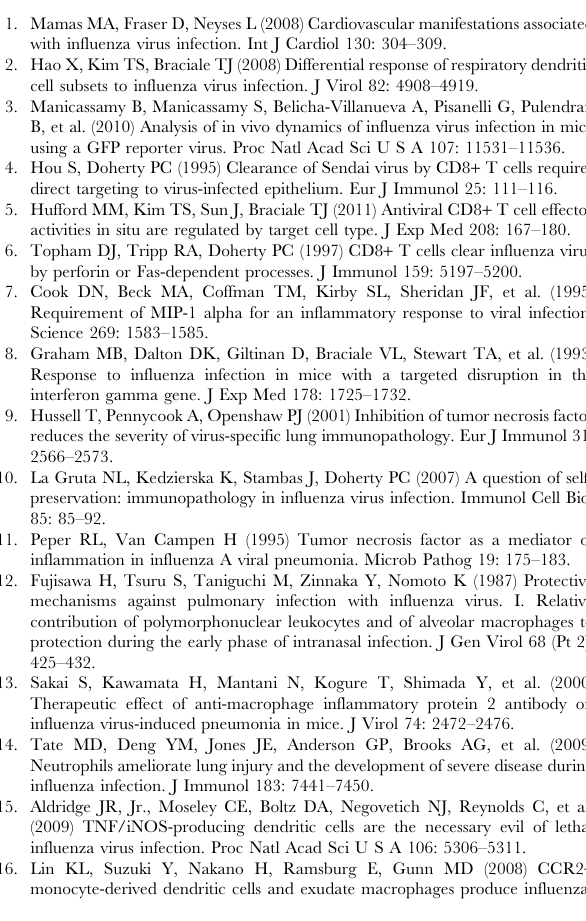
Figure S1 Identification of neutrophils and inflamma- tory mononuclear cells in the infected lung. Representative flow cytometry panels of the lung suspension collected from a day four post infected BALB/c mouse (A/PR/8/34; LD50= 0.1). The cell type has the characteristic FSC/SSC profile of neutrophils. Inflammatory mononuclear cells (B) are a